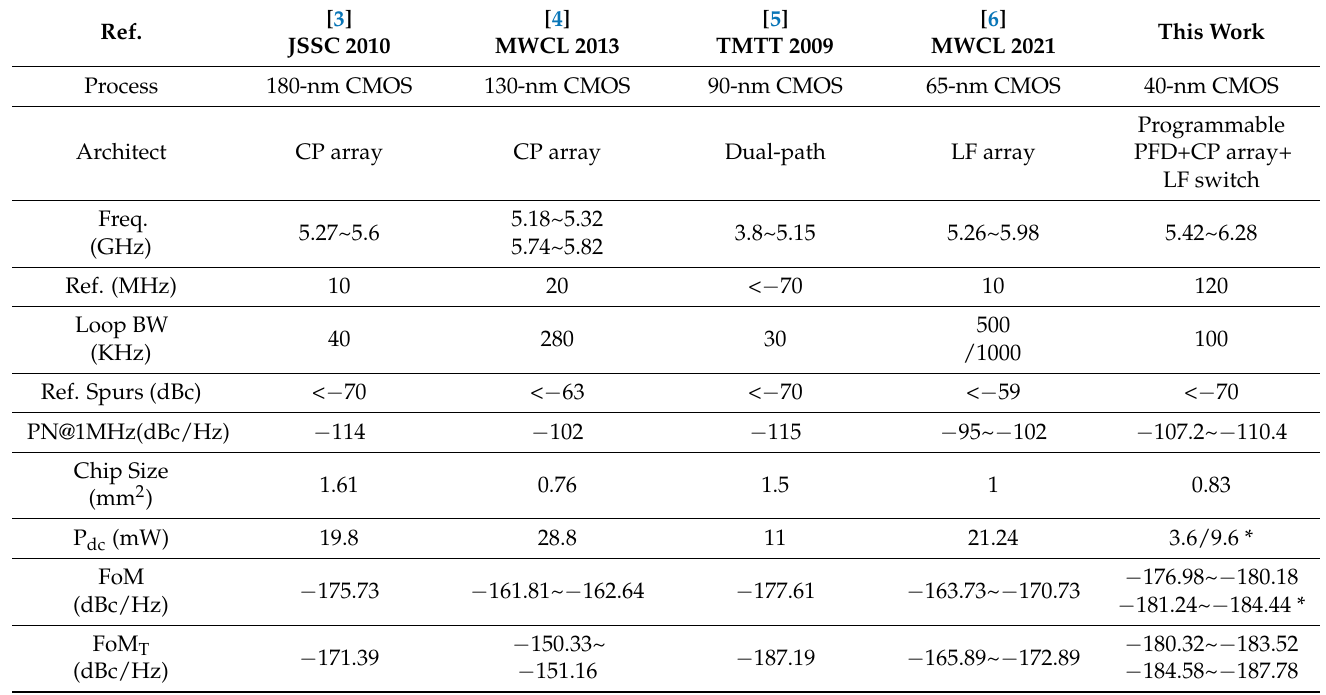
Table 1. Performance specification